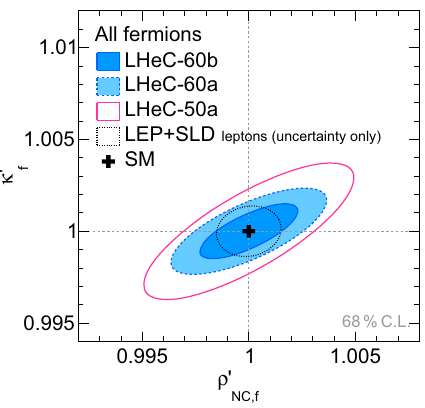
Fig. 11 Expectation for a determination of ρ (cid:9) confidence level, assuming one common anomalous factor for each fermion type. The results for three different LHeC scenarios are com- pared with the relative uncertainties obtained from an analysis of LEP+SLD combined data [62] for leptonic